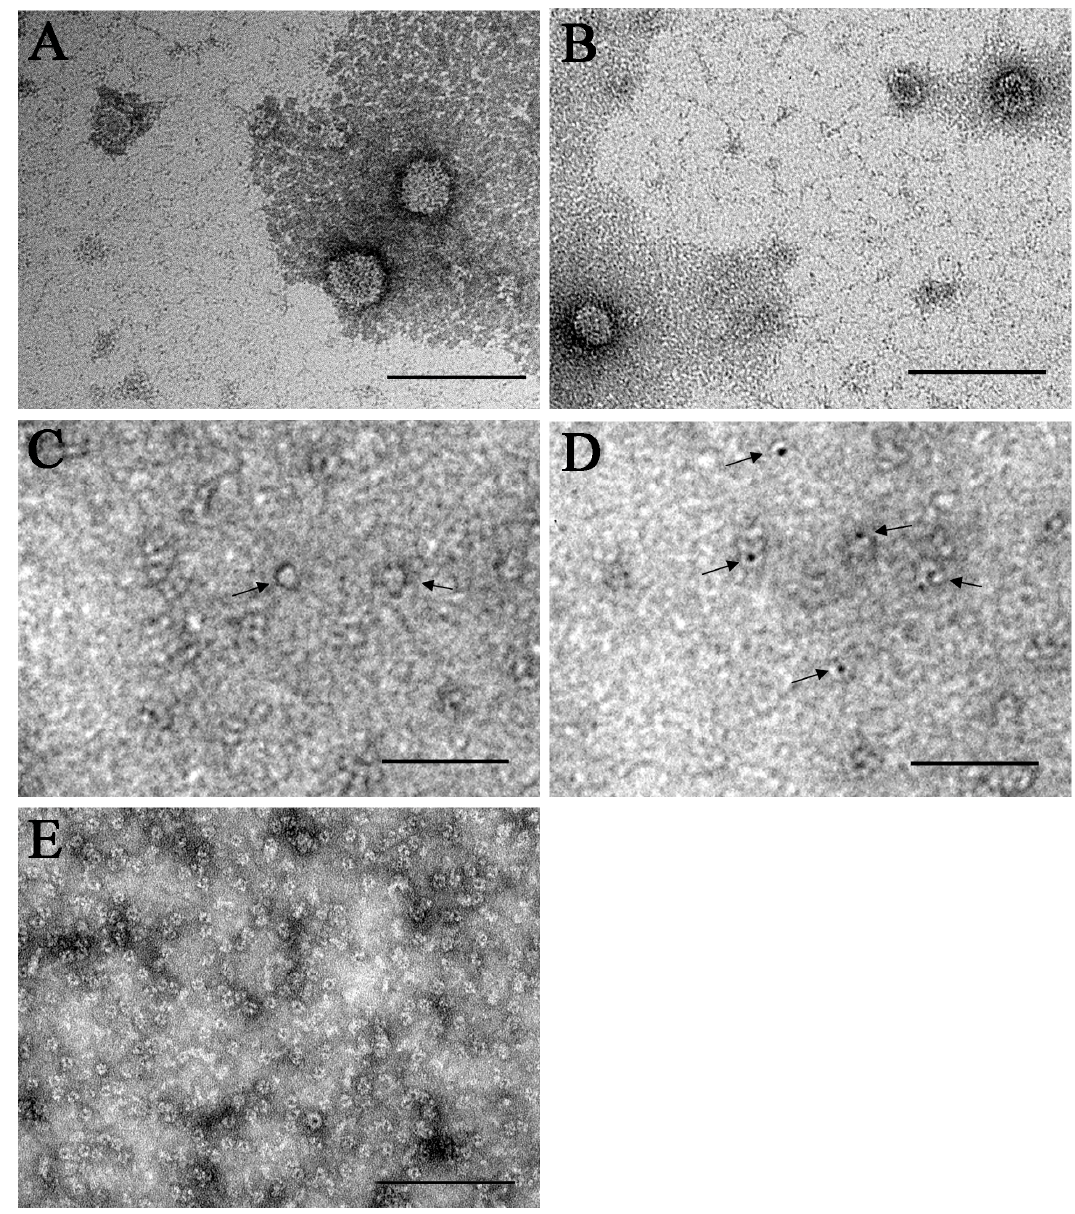
Figure 4. Transmission electron microscopy. Electron micrographs of purified viral particles of the Alongshan virus strain Miass527 propagated in IRE / CTVM19 cells ( A , B ). Small particles with electron-translucent ( C ) or electron-dense ( D ) cores were seen. Small particles with electron-dense cores were also seen in the equivalent fraction of ultracentrifuged supernate from uninfected IRE / CTVM19 cells ( E ). Samples were stained with 2% uranyl acetate. Scale bars, 100